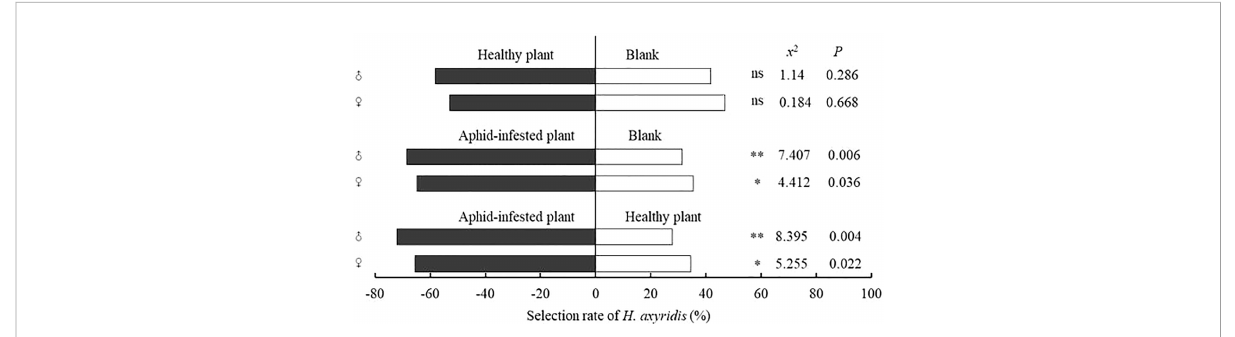
FIGURE 3 Behavioral responses of females and males of H. axyridis adults to different combinations in the Y-tube olfactometer assays. “ * ” denotes a signi fi cant difference at the P < 0.05 level, “ ** ” means P < 0.01; “ ns ” indicates no signi fi cant